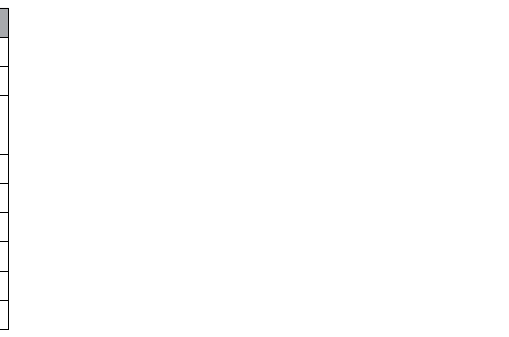
Screening for lipase production. Thermotolerant bacterial isolates were grown aerobically in a glass bot-